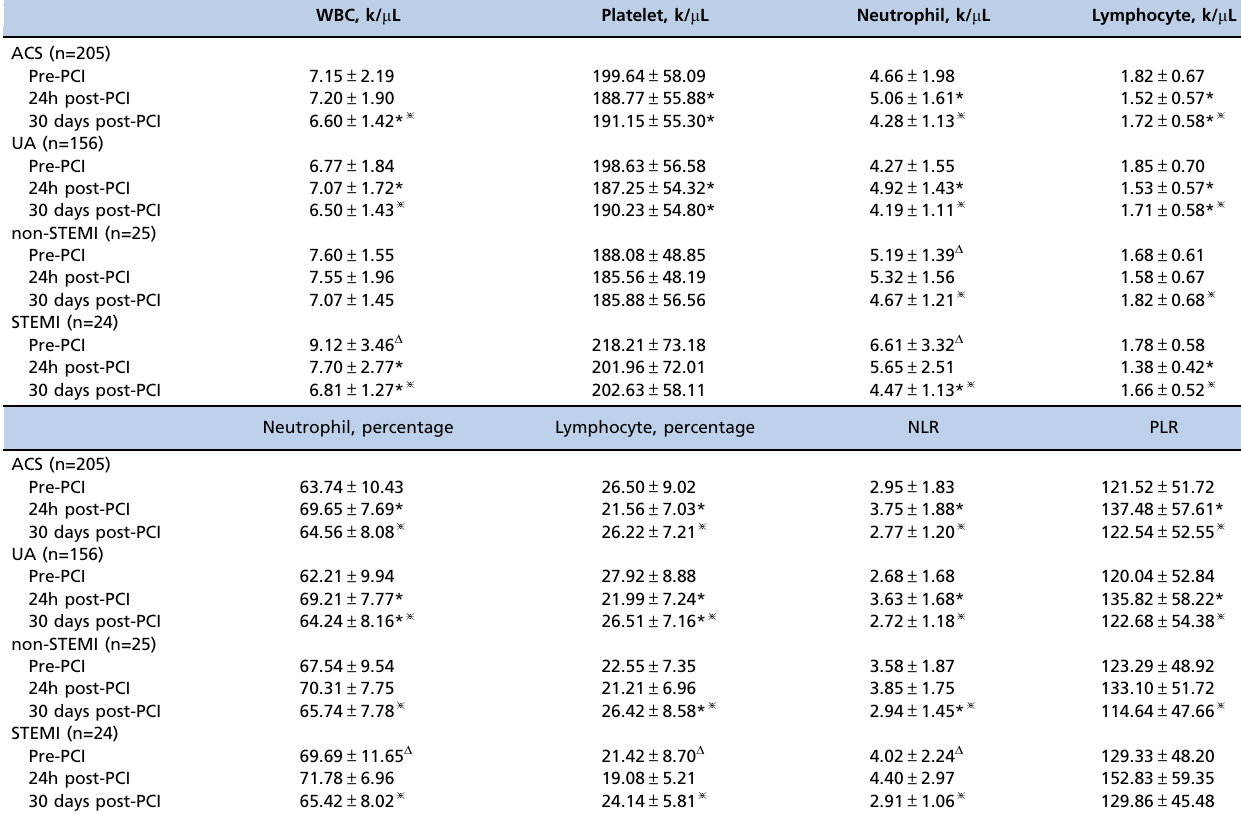
Table 2 - Changes in the preoperative and postoperative blood cell counts in patients with ACS undergoing PCI (n=205). WBC, k/ m L Platelet, k/ m L Neutrophil, k/ m L Lymphocyte, k/ m L ACS (n=205)